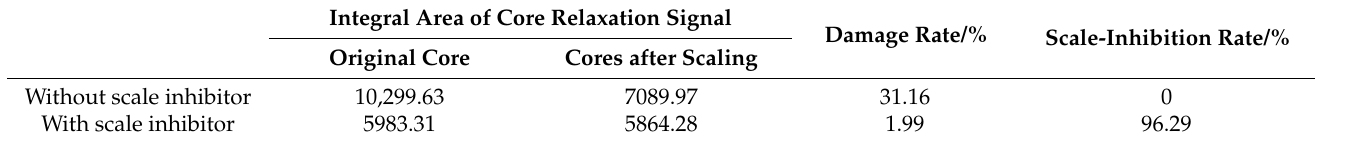
Table 5. Calculation of damage rate and scaling-inhibition rate by NMR.